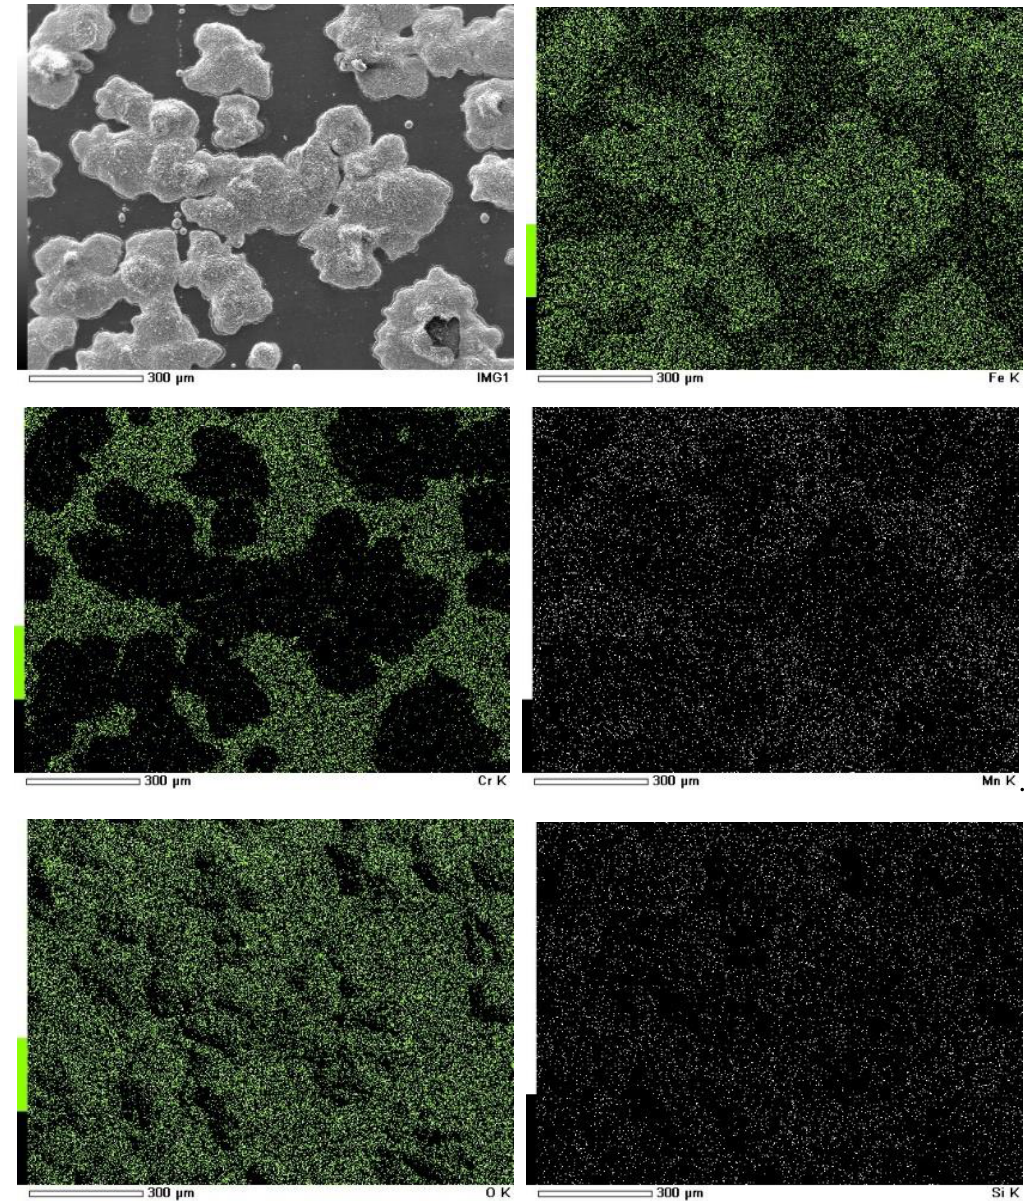
Figure 9. Element distribution of surface oxides on TP347H at 700 °C after 168 h.